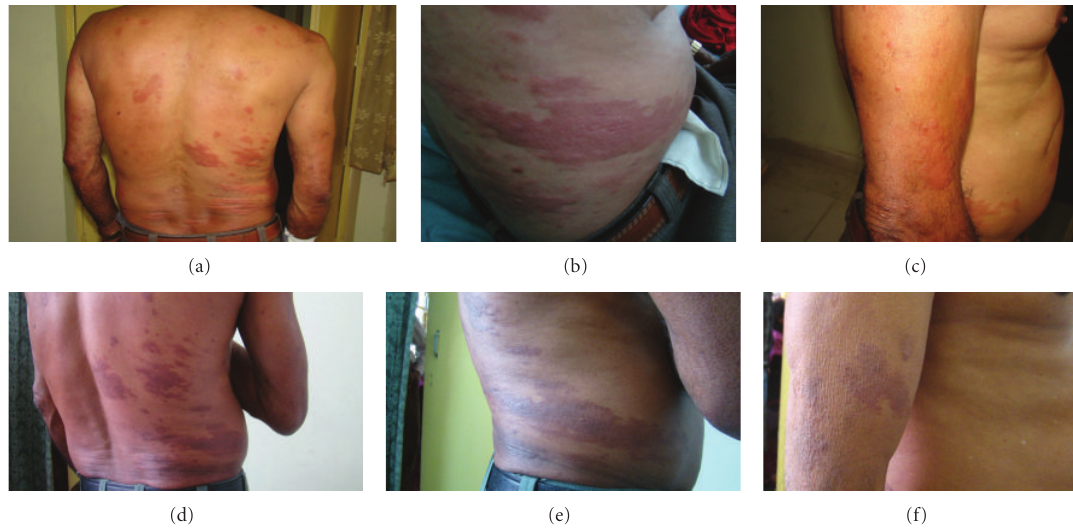
Figure 1: (a-c) Histoid lesions: flesh colored-erythematous papules, nodules, plaques, and patches over back, trunk, arms, and elbows (d&e) Histoid lesions after 6 months’ treatment (f) Histoid lesions at 9-month